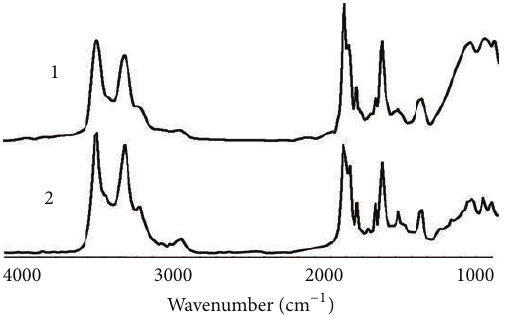
Figure 3: FTIR spectrum of benzamide spot (trace 1) on a narrow- band TLC plate. For comparison, a reference FTIR spectrum of pure benzamide (trace 2) is also included.